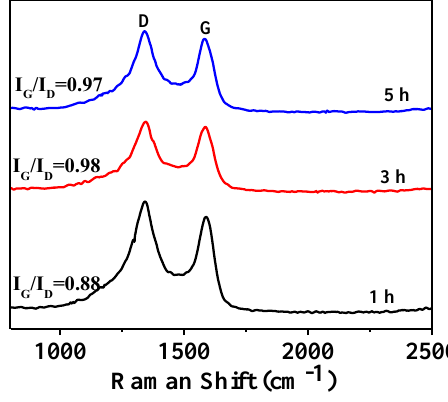
Figure 5. ( a ) XRD patterns of HGCS resulted from heat treatment of presynthesized carbon spheres with 1.0 wt % Fe at 900 °C for different times and ( b ) magnification of the XRD patterns within 40°– 50° (ICDD: 01-075-1621 (Graphite), 01-089-7194 (Fe), and 01-089-0688 (Fe 3 O 4 )).